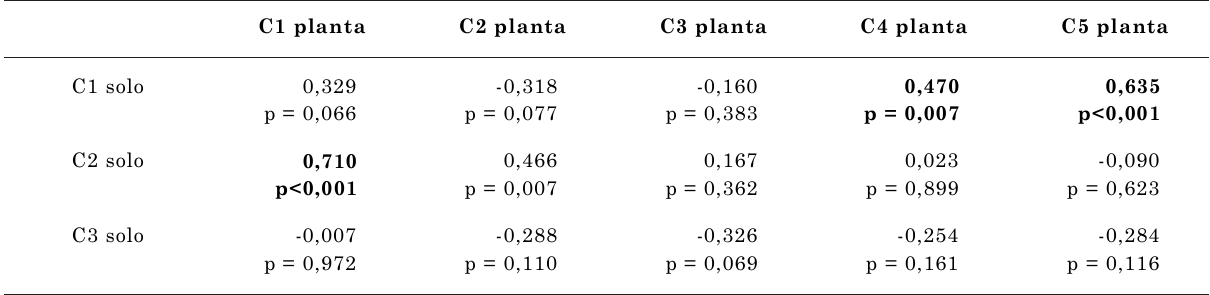
Quadro 10. Análise de correlação entre os “scores” dos componentes ligados à fertilidade do solo e os “scores” dos componentes formados pelos nutrientes nas folhas do eucalipto, retidos na análise de componente